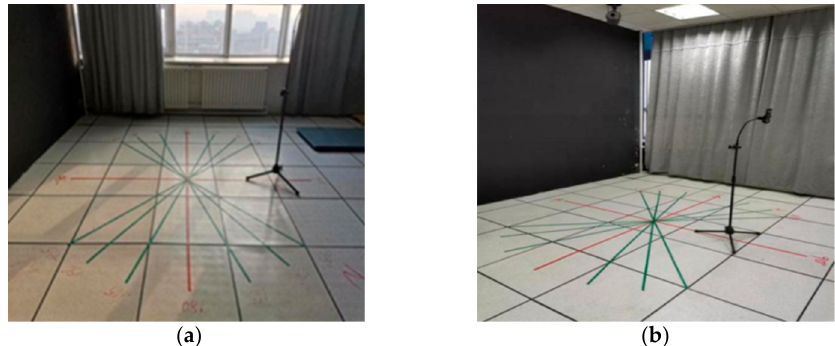
Figure 2. Collection environment of human ear database; ( a ) strong light; ( b ) weak light.